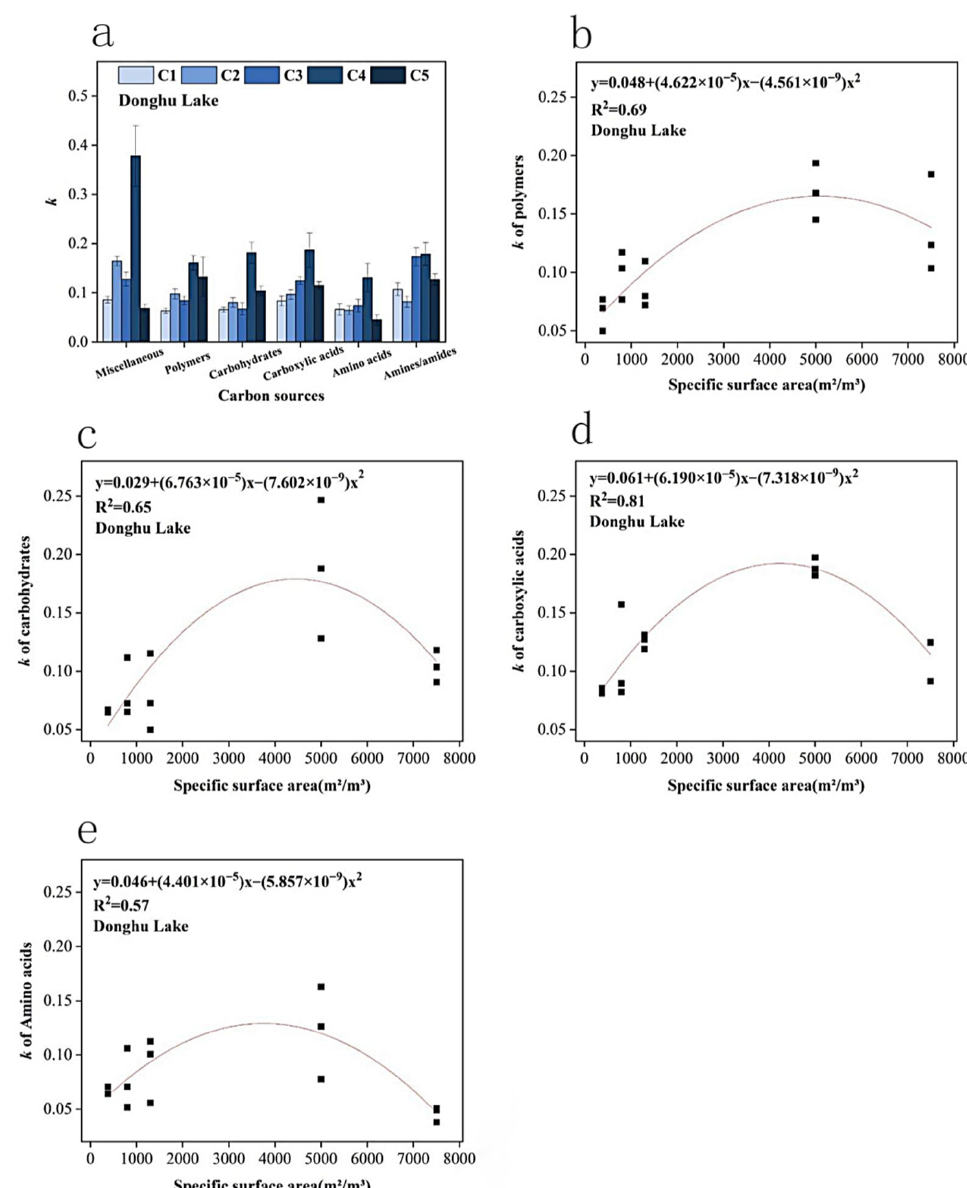
Figure 4. The carbon metabolism rate of biofilm attached to five carriers with different specific surface areas (C1–C5) in Donghu Lake ( a ), and the fitting curve between carbon metabolism rate of specific carbon sources (polymers, carbohydrates, carboxylic acids and amino acids) and carriers’ specific surface area in this lake ( b – e